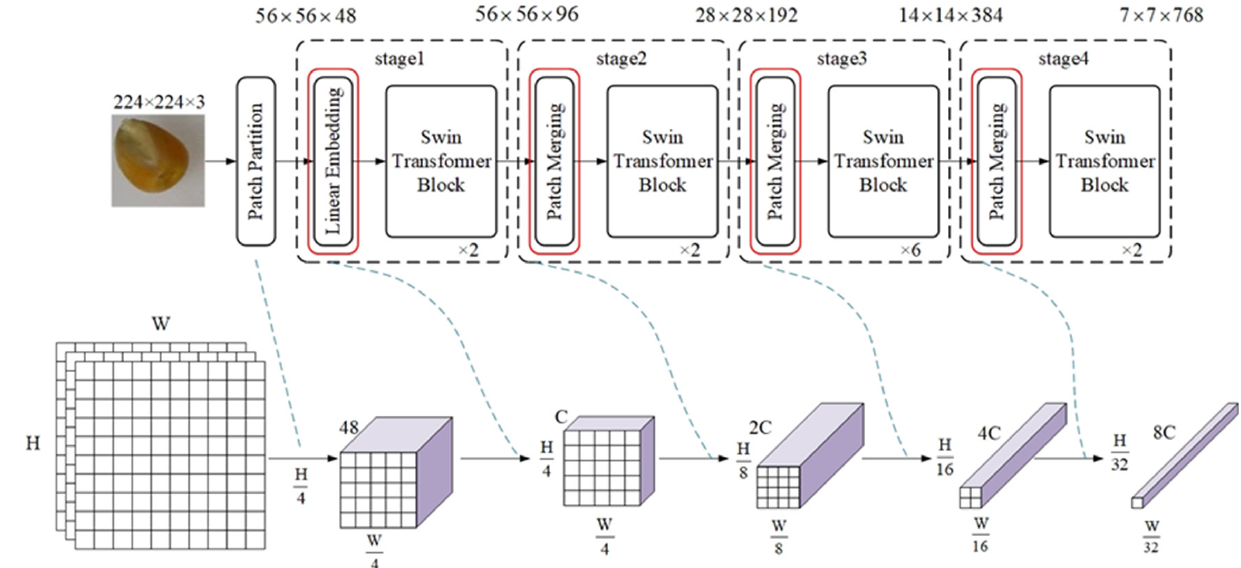
Figure 7. Swin Transformer model structure diagram.